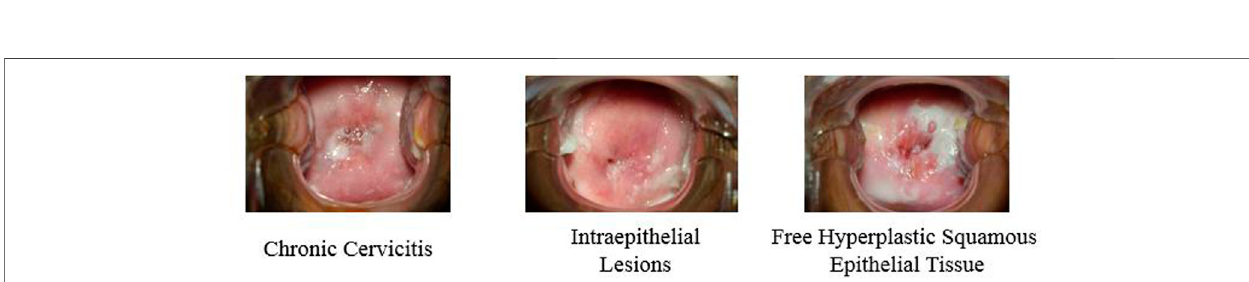
FIGURE 4 | Process of training and validation for all classes.